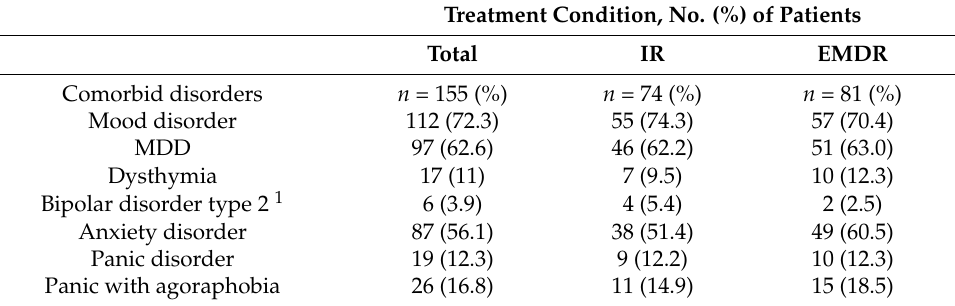
Table 1. Psychiatric comorbidities of the IREM